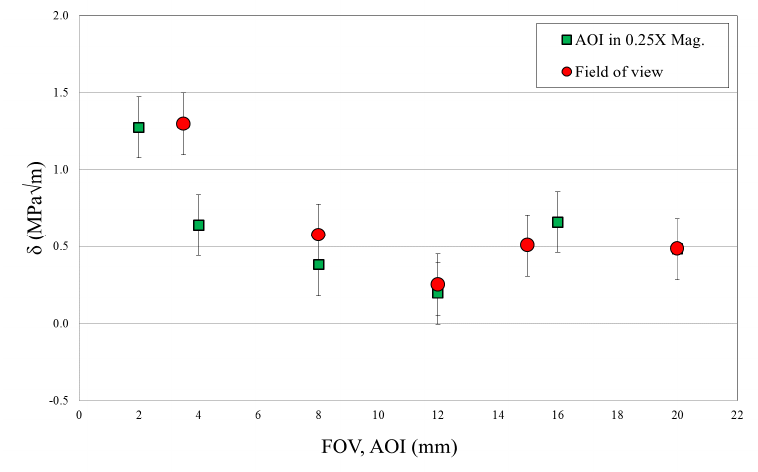
Figure 6. Comparison between the effect of the AOI and FOV on